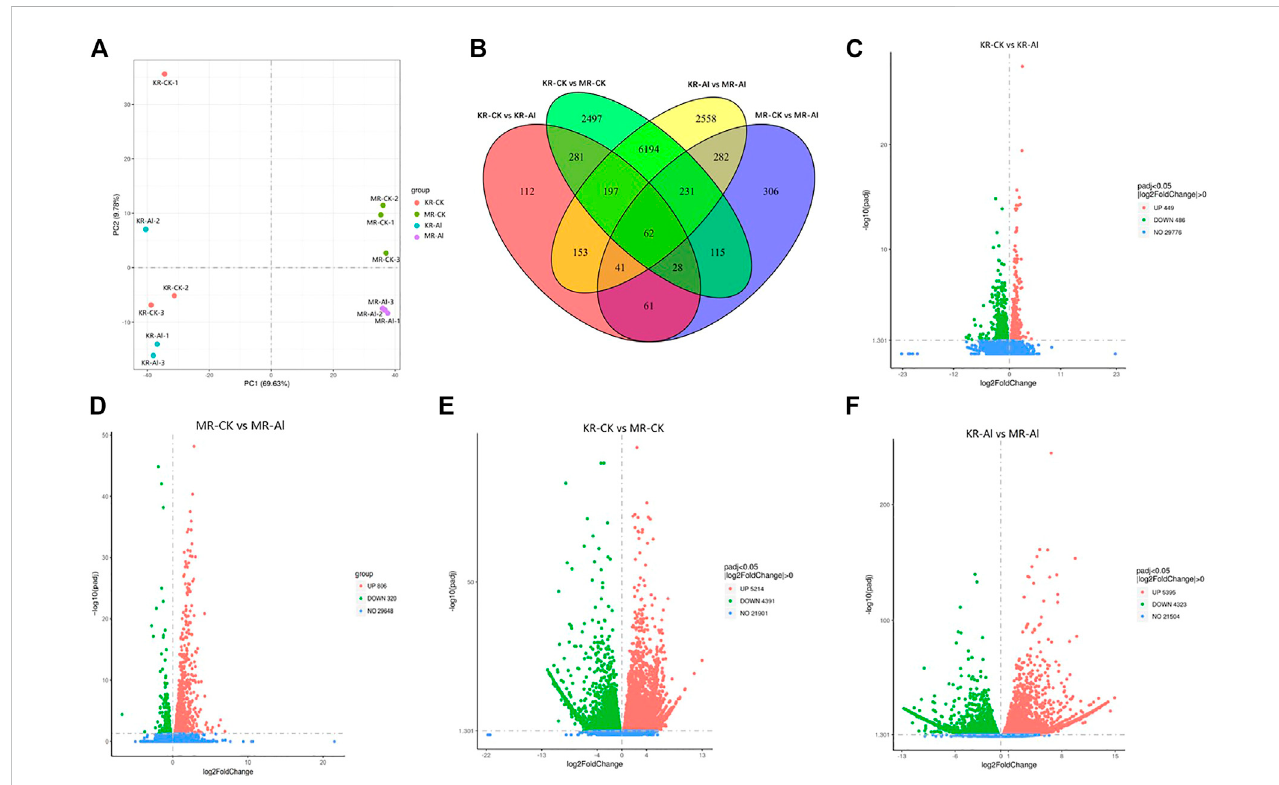
FIGURE 2 Transcriptomics changesoftworicelandraces underAlstress. (A) PCAanalysis ofdifferenttreatmentgroups. (B) Venngraphfor thecomparisons ofKR- CK vs. KR-Al and MR-CK vs. MR-Al. (C) Volcano plots of DEGs between KR-Al and KR-CK. (D) Volcano plots of DEGs between MR-Al and MR-CK. (E) Volcano plots of DEGs between KR-CK and MR-CK. (F) Volcano plots of DEGs between KR-Al and MR-Al. The dots: differential DEGs, Green dots: downregulated DEGs, Red dots: upregulated DEGs, Blue dots: detected DEGs without